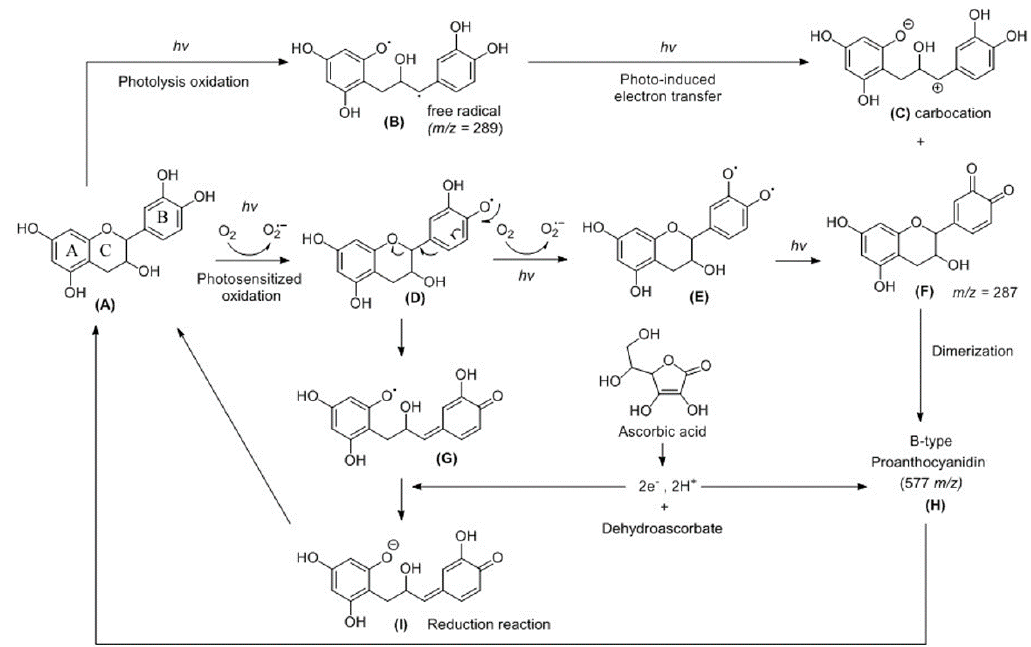
Figure 7. Proposed scheme for the photoreaction mechanism of catechin and interactions of intermediates with ascorbic acid.